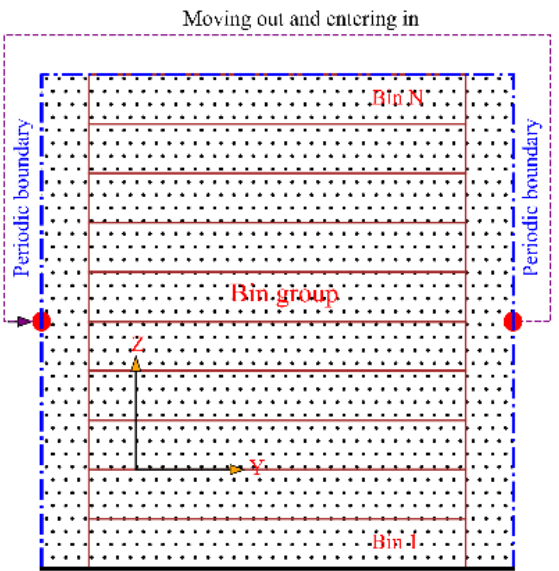
Figure 3. Packing container.